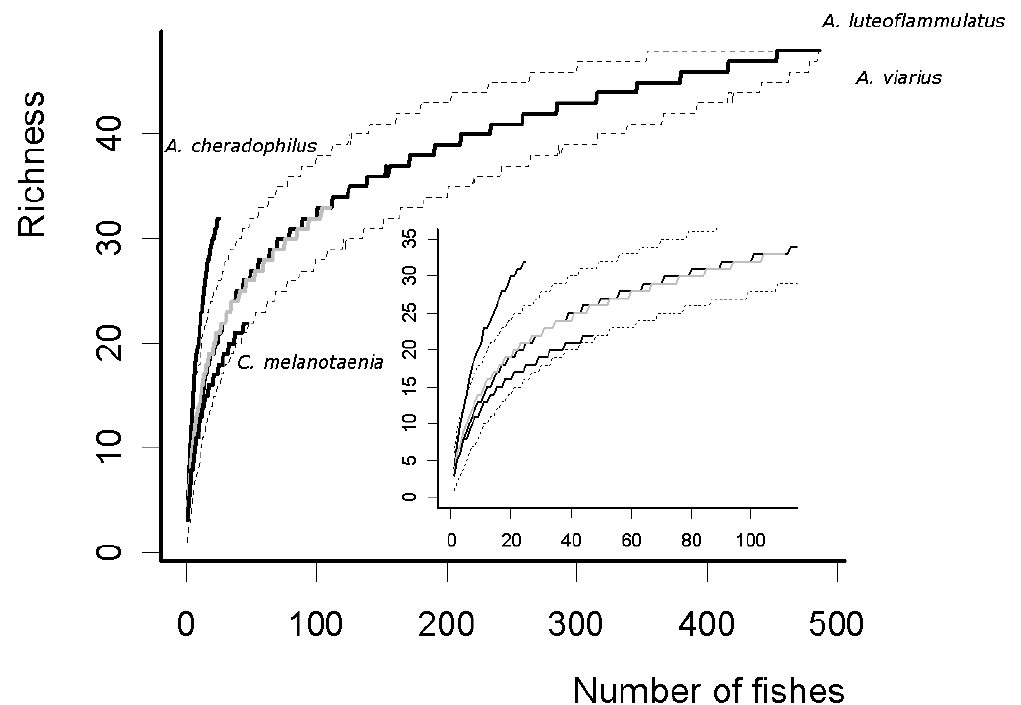
Fig. 6. Rarefaction curves applied for the categorized diet items of Cynopoecilus melanotaenia , Austrolebias luteoflammulatus , A. viarius and A. cheradophilus . Dashed lines indicate the confident interval at 95%.